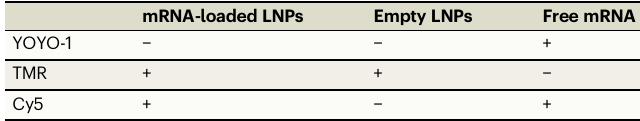
Table 1 | Differentiation strategy to distinguish different spe- cies in LNP formulations based on fl uorescence coincidence